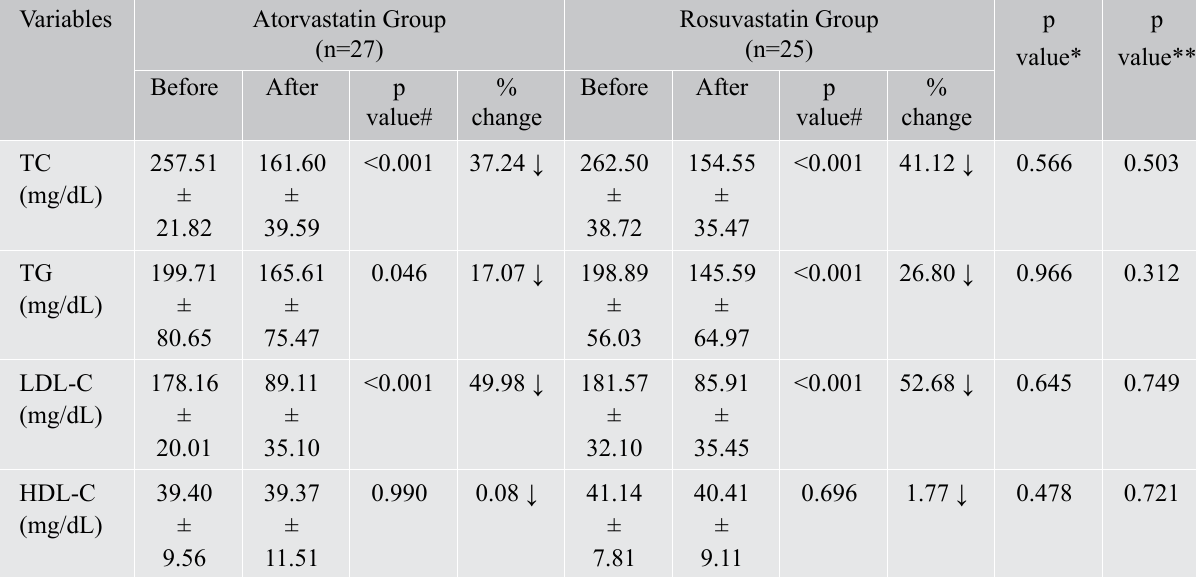
Table III: Effect of atorvastatin and rosuvastatin on serum lipid